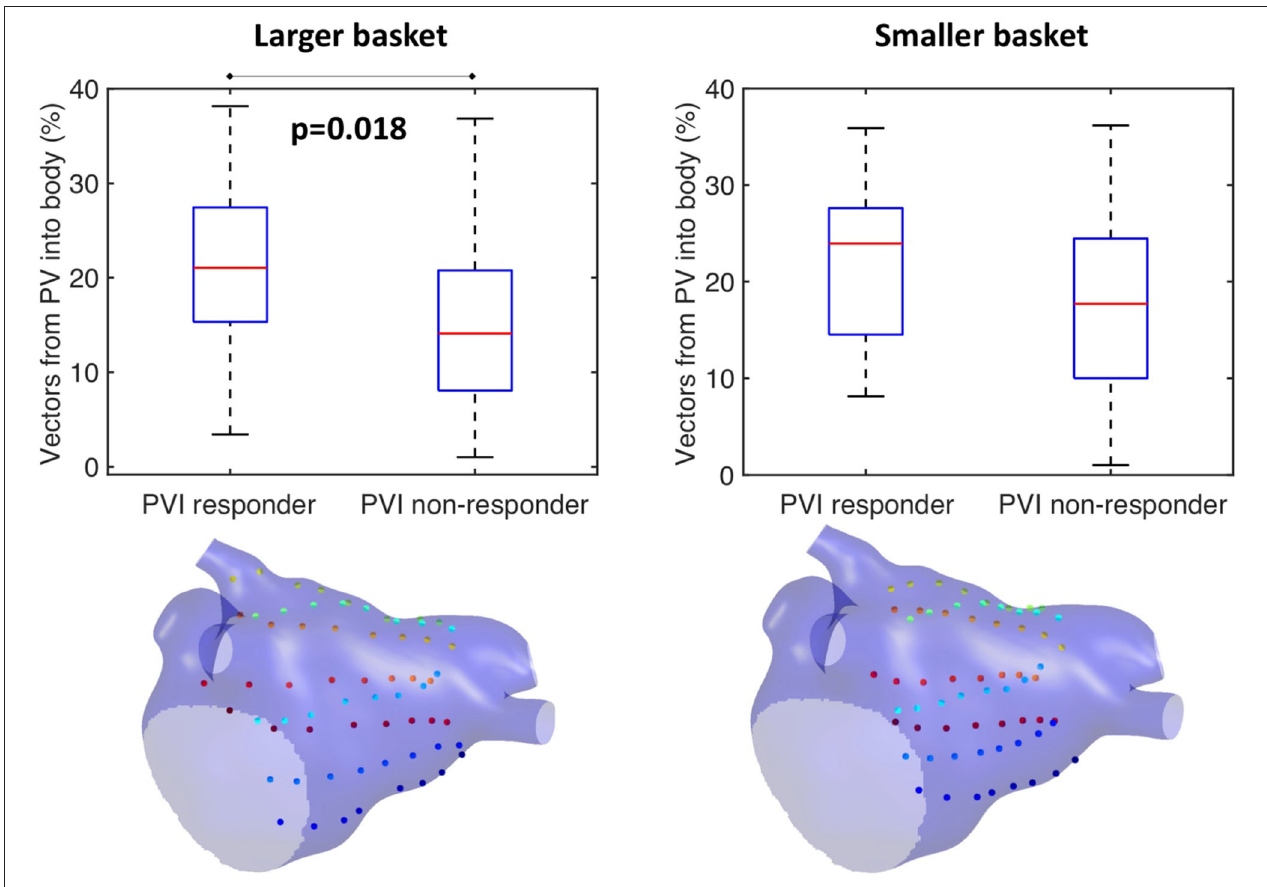
FIGURE 10 | Effects of basket size on preferential pathways. Reducing the basket size changed the significance of the PV flow metric: larger basket: median 21.1 vs. 14.1%, p = 0.018, Wilcoxon signed-rank median; smaller basket: 24 vs. 17.7%, not